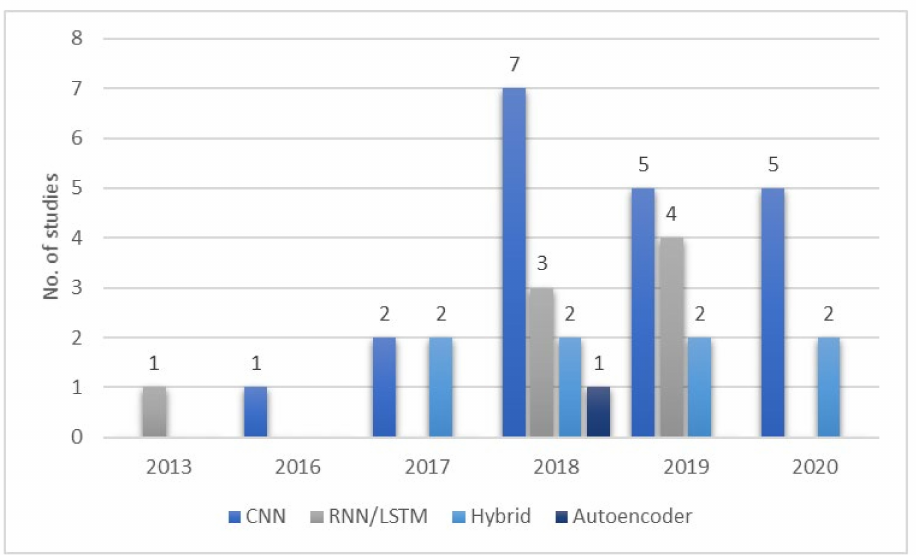
Figure 14. Number of studies published between 2013 and 2020 describing implementation of various DL models for PSG recording analysis. * Summary statistics: year of the analyses for various deep learning models used in sleep